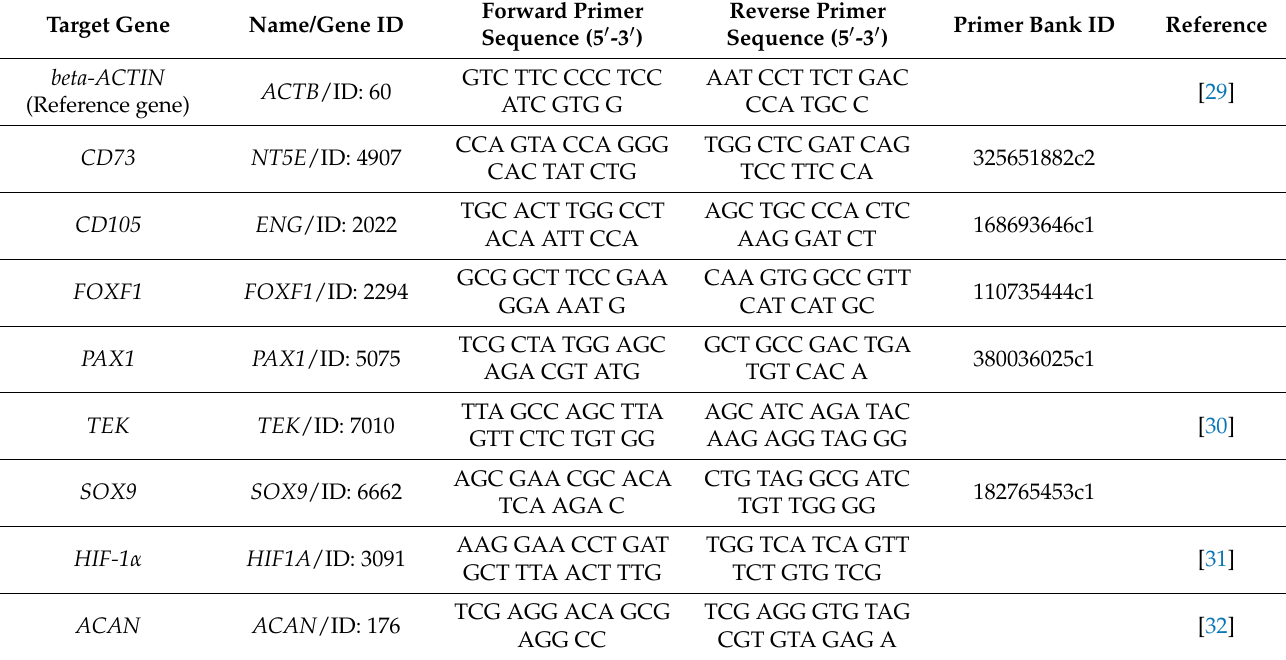
Table 2. qPCR primer